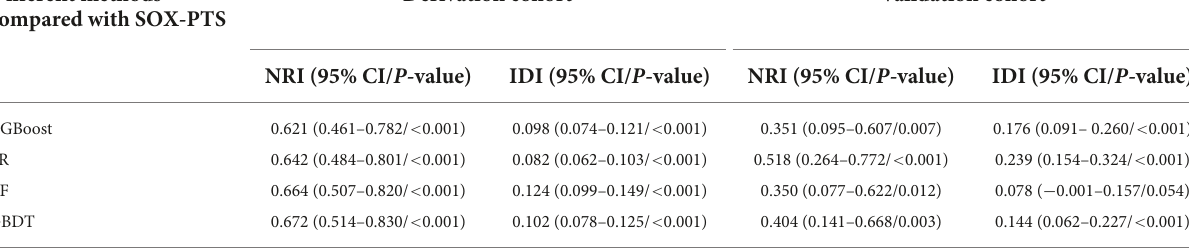
TABLE 2 Net reclassification improvement and integrated discrimination improvement results of machine learning models compared with the SOX-PTS score. Different methods compared with